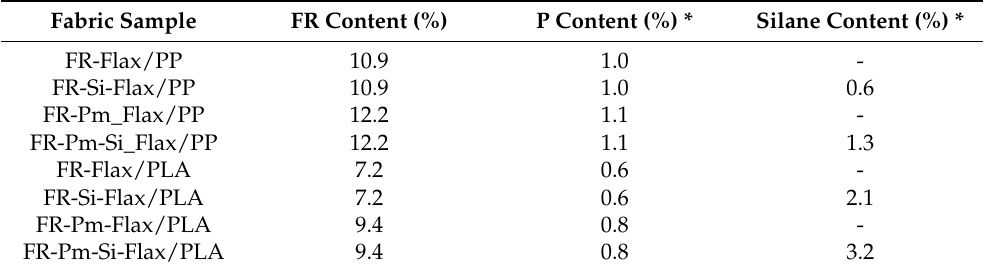
Table 3. Flame retardant Flax/PP and Flax/PLA laminates treated with different surface modification